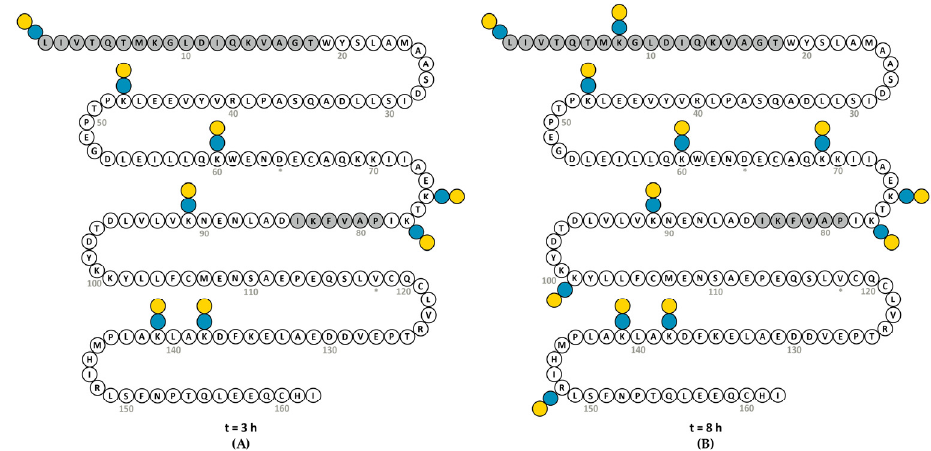
Figure 5. ( A ): after 3 h, lactosylation occurred at L1 (N-terminus), K47, K60, K75, K77, K91, K138 and K141 of BLGWT. ( B ): after 8 h additional sites K8, K69, K101 and R148 were lactosylated. Lactose moieties are indicated by yellow/blue bispheres. In grey: non-binding areas of the pool of BLG-specific chimeric IgE monoclonal antibodies used in the RBL assay. * BLGB = BLGA D64G, V118A.